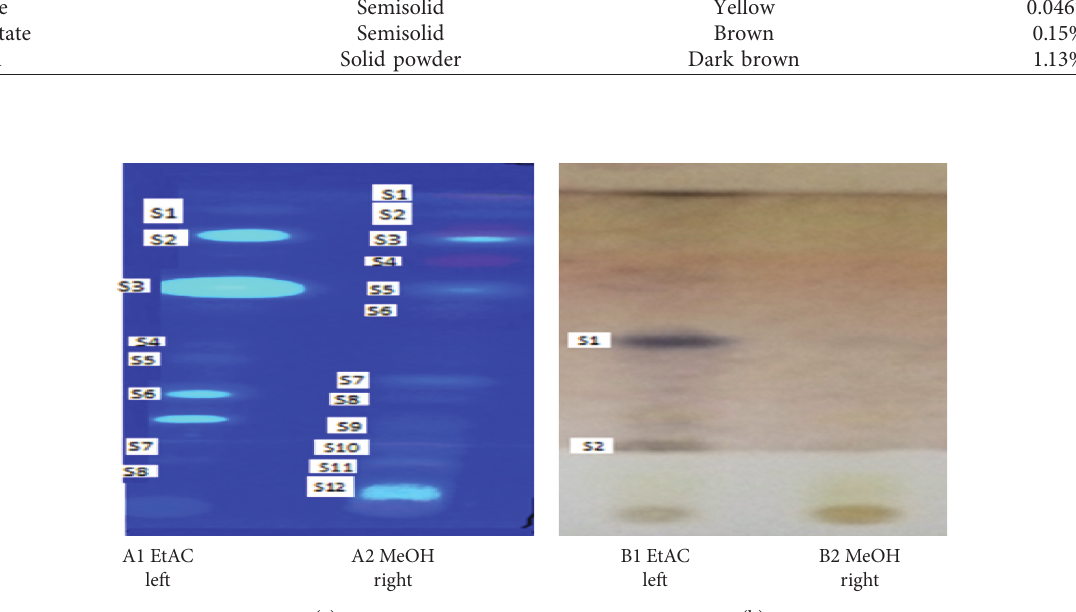
Figure 2: TLC separation of different extracts for chemical constituents of Senna occidentalis root by using solvent system toluene: ethyl acetate with the ratio 70:30. Keys: (a) before spray under UV and (b) after spray with anisaldehyde sulpharic acid reagent. S ≡ spot of separation.